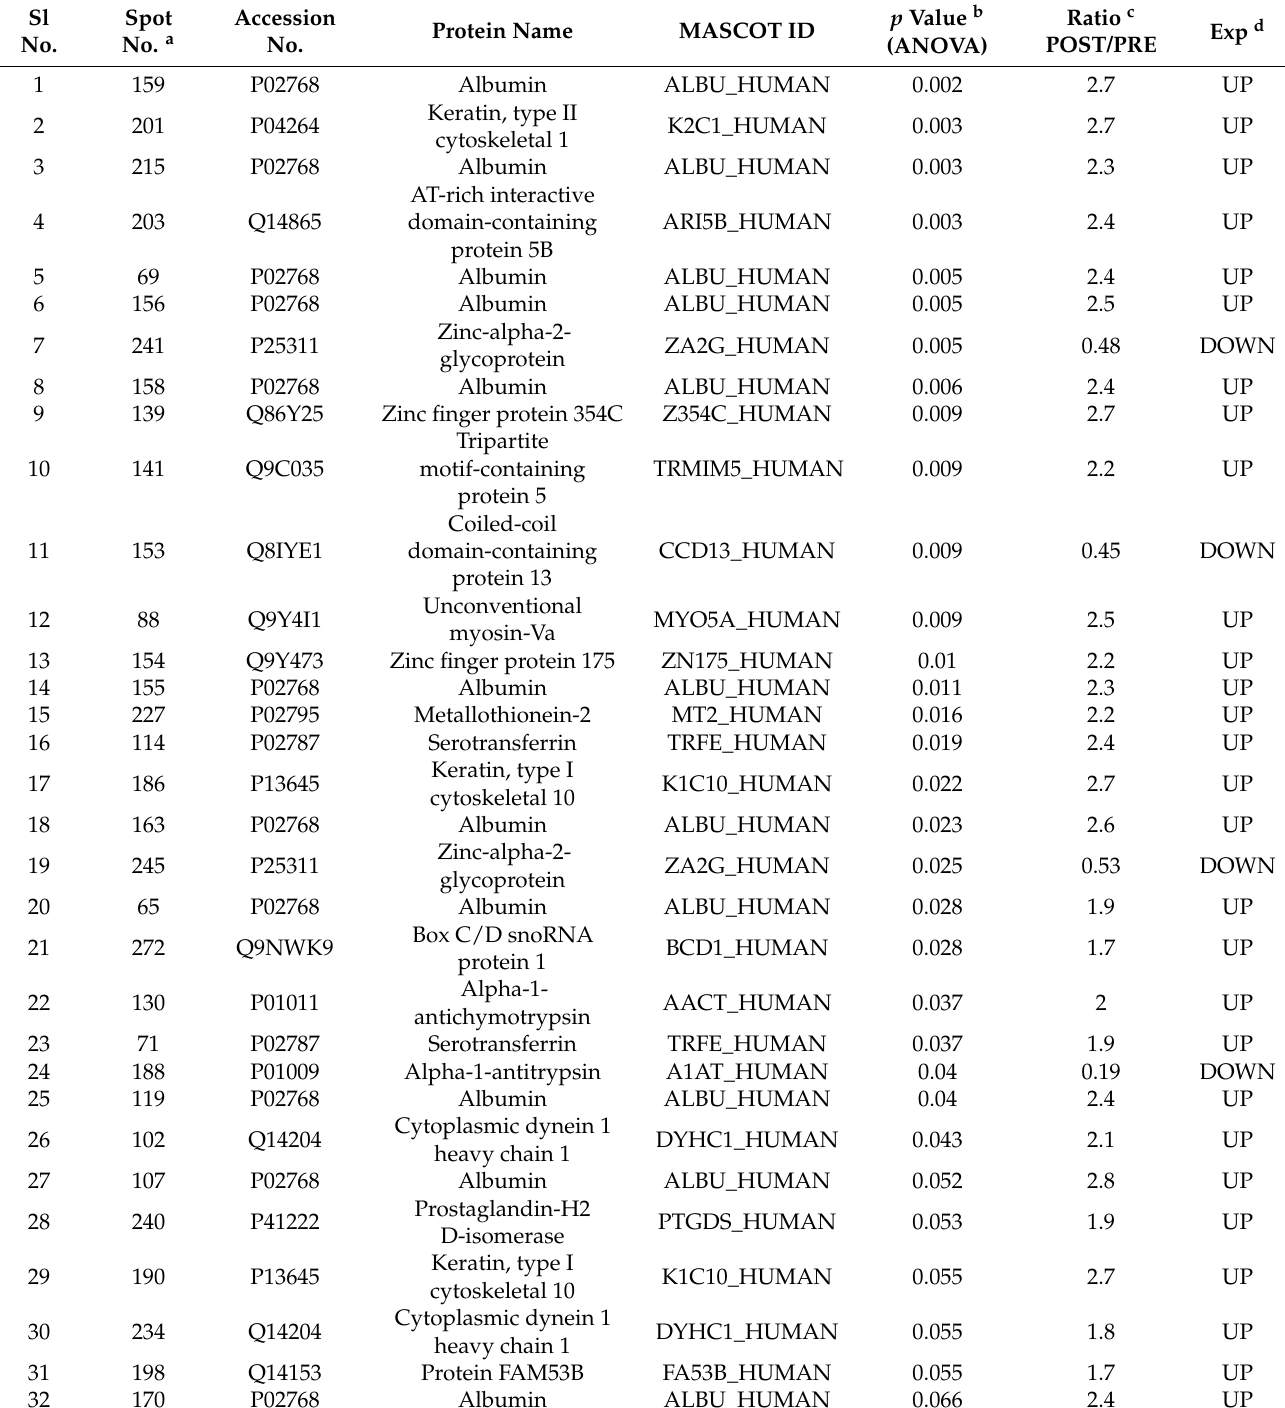
Table 2. List of proteins identified with changes in abundance between liraglutide pre-treated and post-treated in urine samples. Values for the average ratio between the two states are shown with their corresponding levels of fold changes and one-way ANOVA ( p < 0.05) using 2D-DIGE. Analysis type: MALDI-TOF; database: SwissProt; taxonomy: Homo